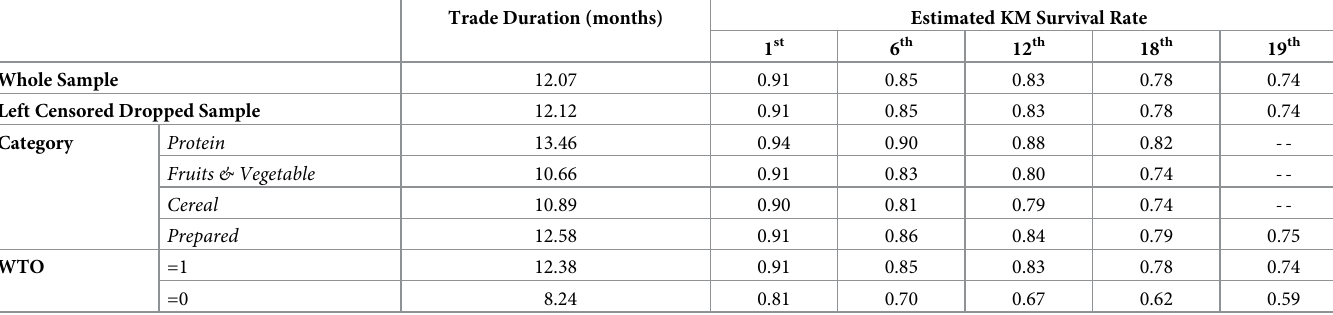
Table 4. Kaplan-Meier estimators of China’s agricultural imports.